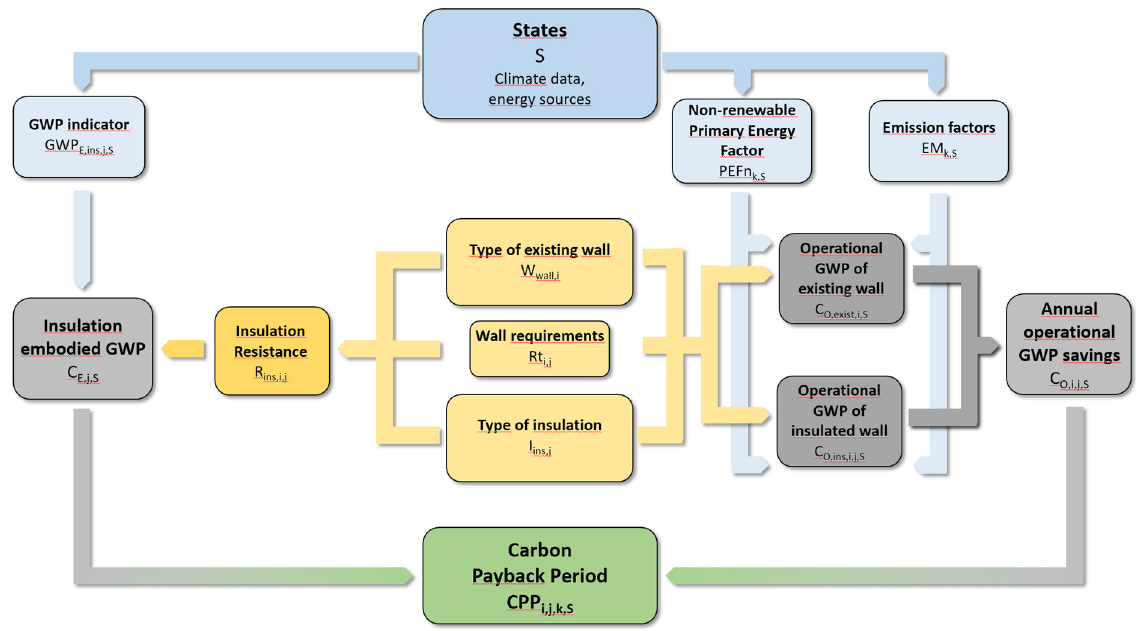
Figure 2. Scheme of the CPP calculation